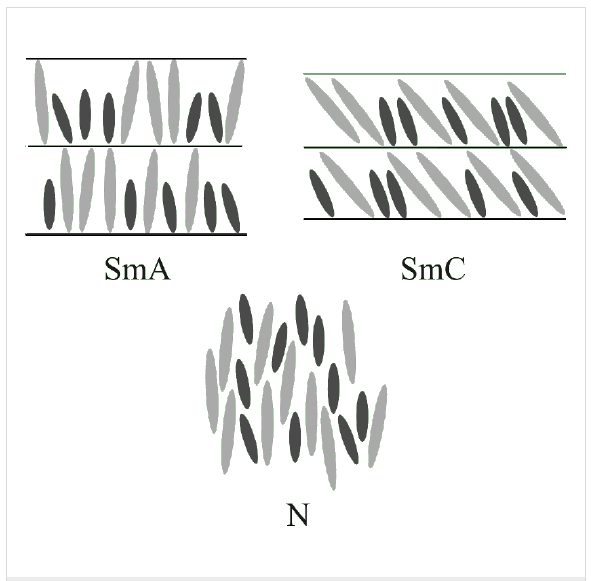
Figure 1: Structure of different liquid crystalline phases build with two kinds of hard spherocylinders with strongly differing